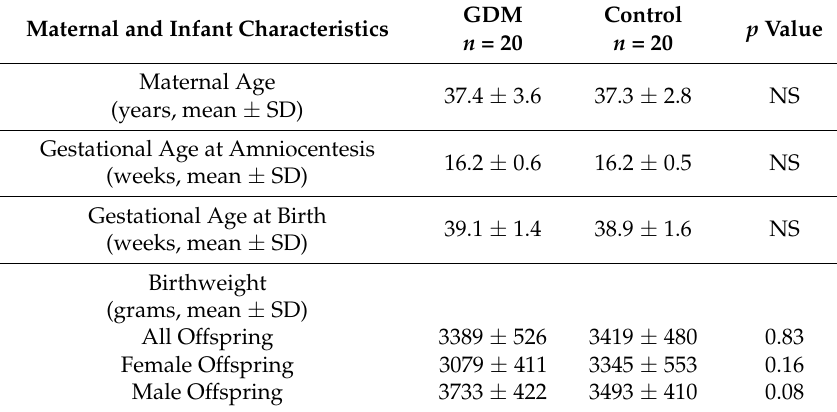
Table 1. Maternal and infant